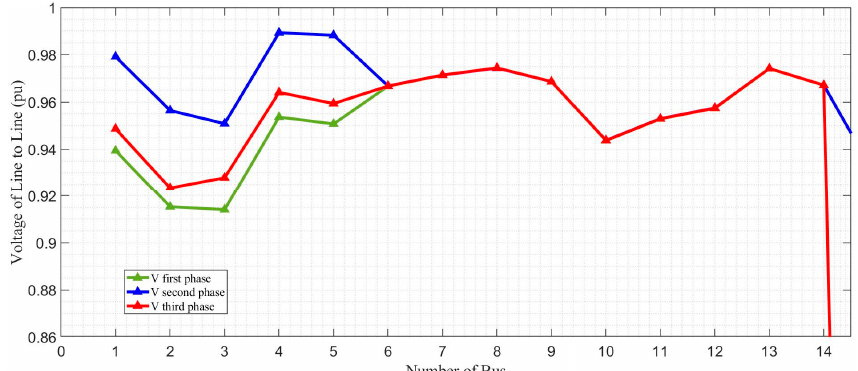
Figure 7. Maximum demand voltage.